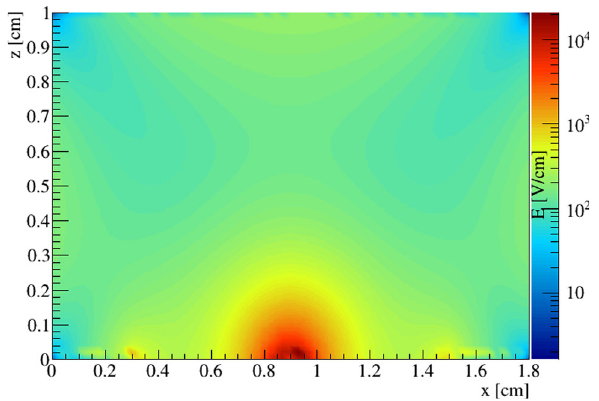
Fig. 14 The electric field distribution in the detector when a positive voltage of 900 V was applied to the outside surface contact